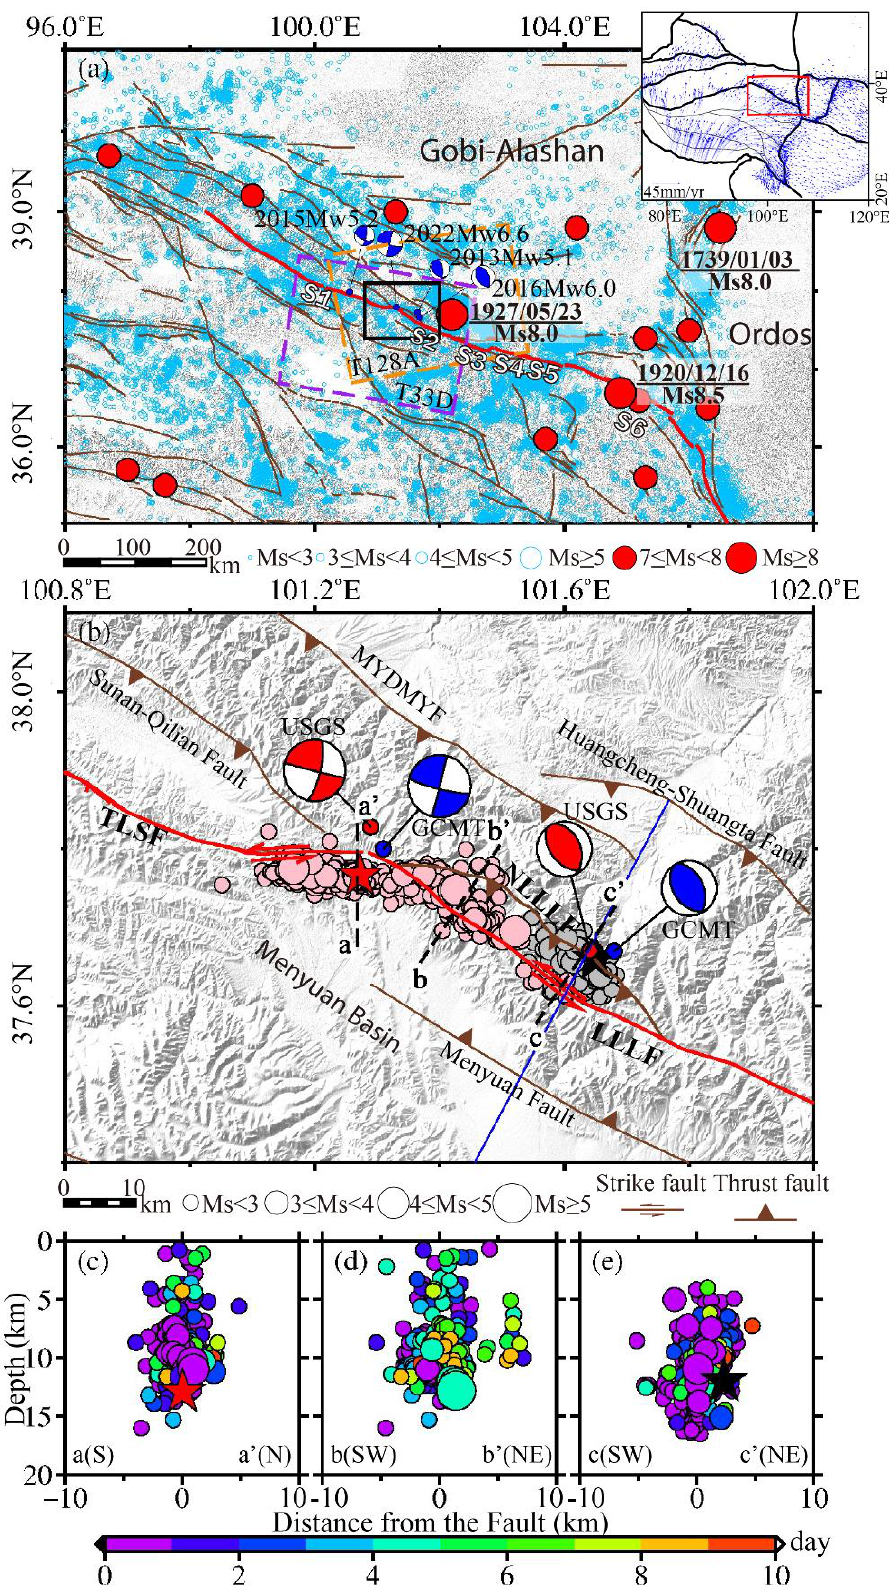
Figure 1. ( a ) Tectonic setting along the northeastern margin of the Tibetan Plateau. The active faults (brown lines) are from Xu et al. [35] and Guo et al. [36]. Red line marks the Qilian-Haiyuan fault system. The blue beach balls are the GCMT focal mechanisms of earthquakes (Mw > 5.0) from 2012 to 2022. The light blue circles are small and moderate earthquakes (<Ms 6.0) between 2009 and 2020 from the China Earthquake Networks Center. Red dots show the historical earthquakes with Ms > 7.0. The dashed rectangles represent the footprint of the SAR data. Black rectangle outlines the ex- tent shown in Figure 1b. The red rectangle in the inset map indicates the location of Figure 1a. The inset map shows the interseismic GNSS velocities from Wang and Shen [37]. Segments of the Qilian- Haiyuanfault system: S1: Tuolaishan, S2: Lenglongling, S3: Jinqianghe, S4: Maomaoshan, S5: